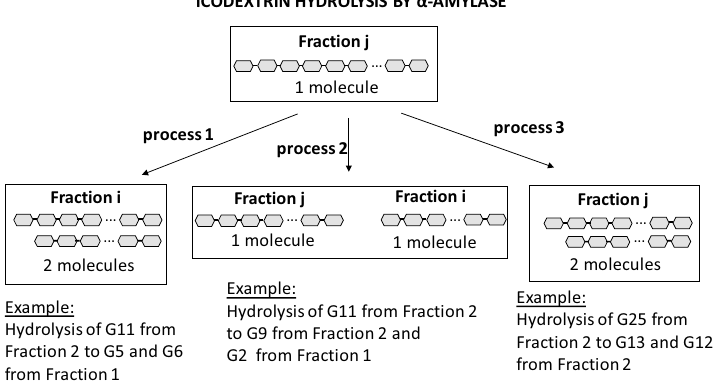
Figure 3. Three possible outcomes of the hydrolysis of icodextrin polymers and their impact on the change of molar mass of icodextrin